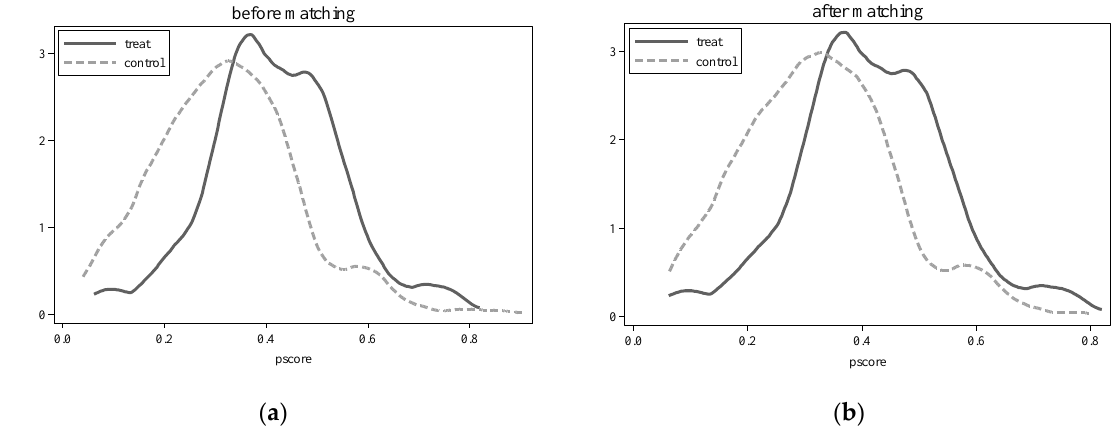
Figure 3. probability distribution density function of tendency score value. Figure 3. Probability distribution density function of tendency score value. Table 4. Regression results for robustness test. Table 4. Regression results for robustness